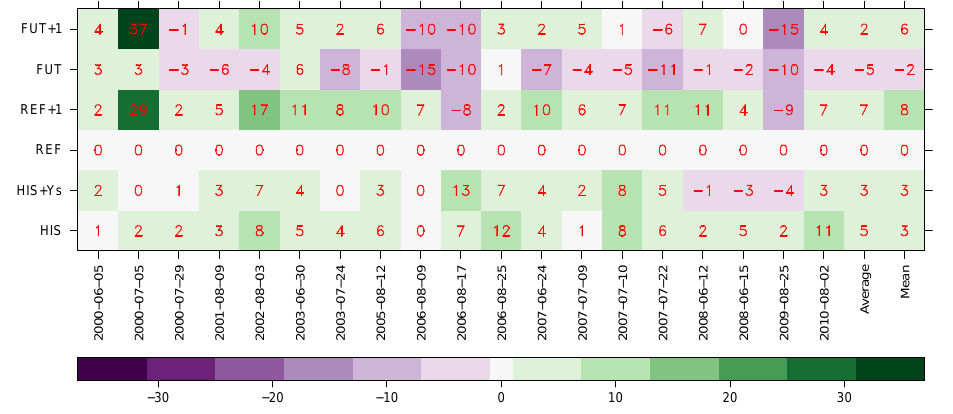
over a different number of cases (14 vs. 18,